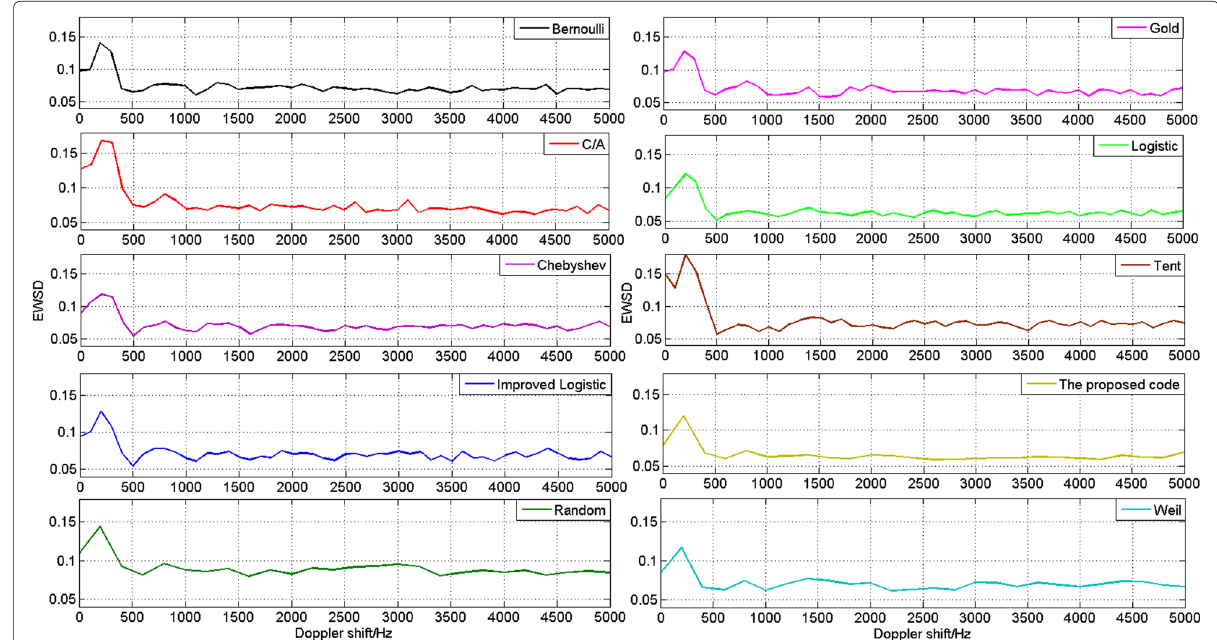
Fig. 8 Relation curves between Doppler shift and EWSD of 10 different